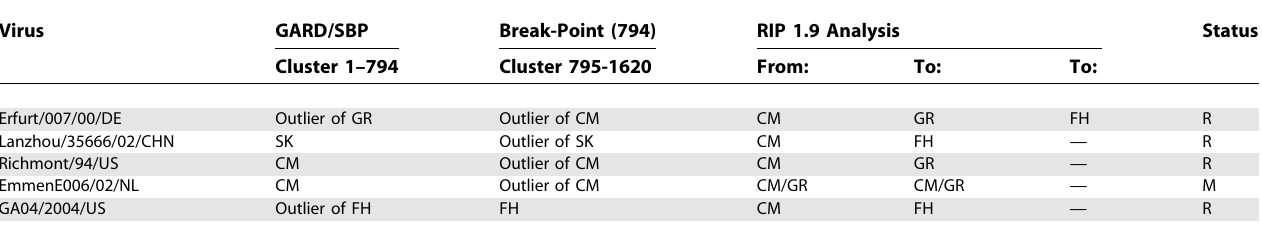
Table 3. Recombination Detection Analysis